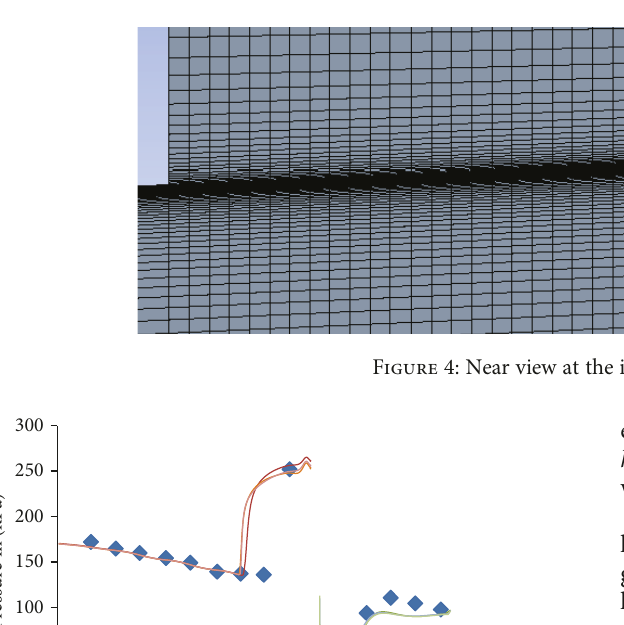
Figure 3: Computational structured grid 2.